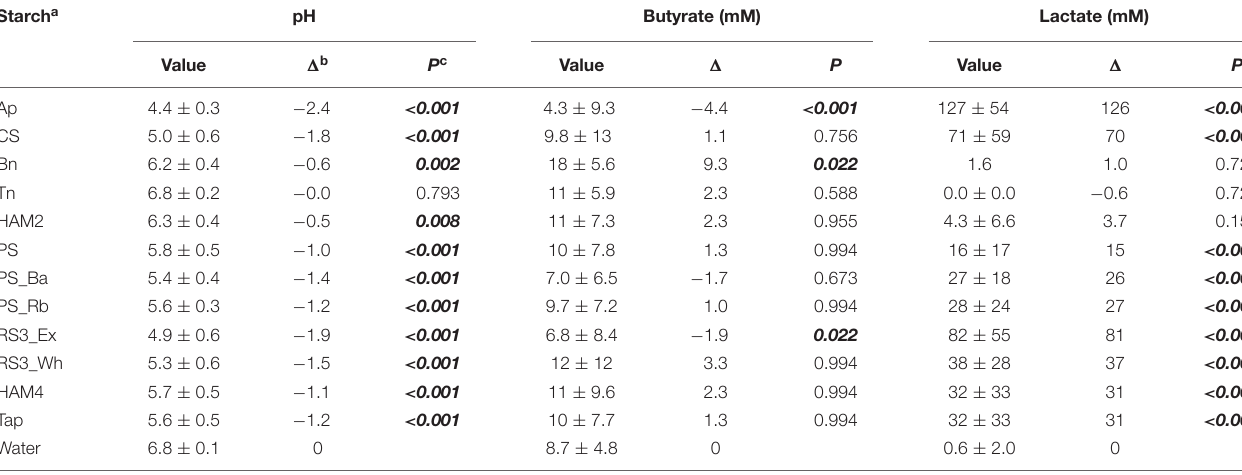
TABLE 1 | Differences in fermentation parameters between treatments and control averaged across all inocula. Starch a pH Butyrate (mM) Lactate